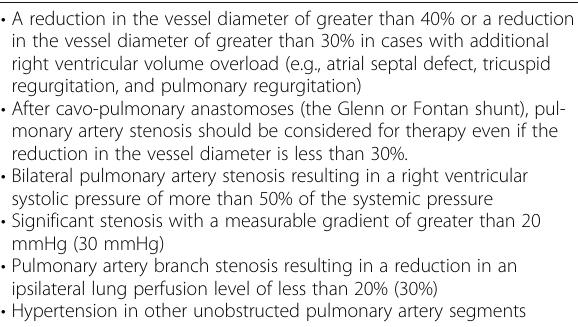
Table 2 Indications for the treatment of peripheral pulmonary artery stenosis [7,